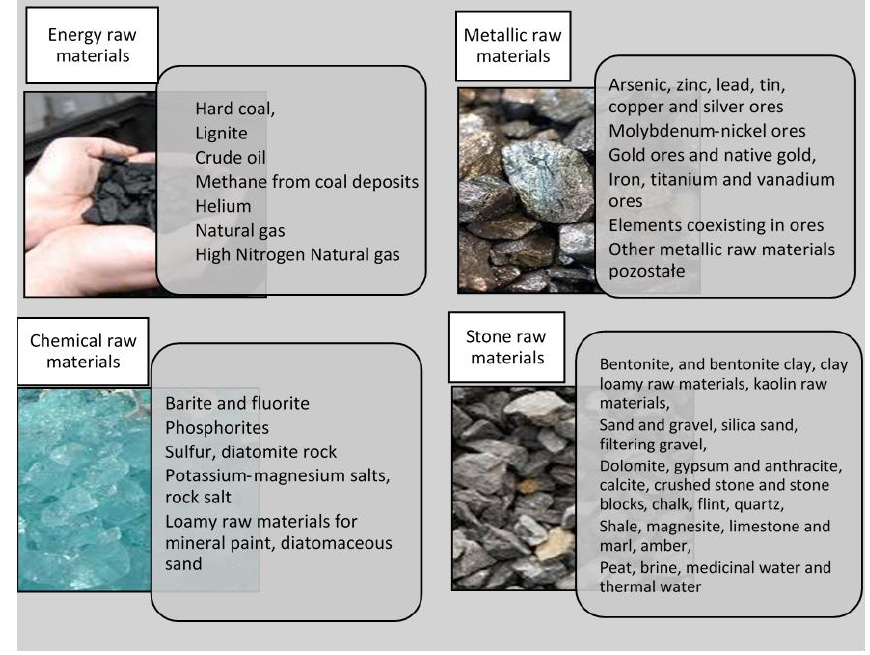
Figure 1. Groups of mineral raw materials in Poland (own study).